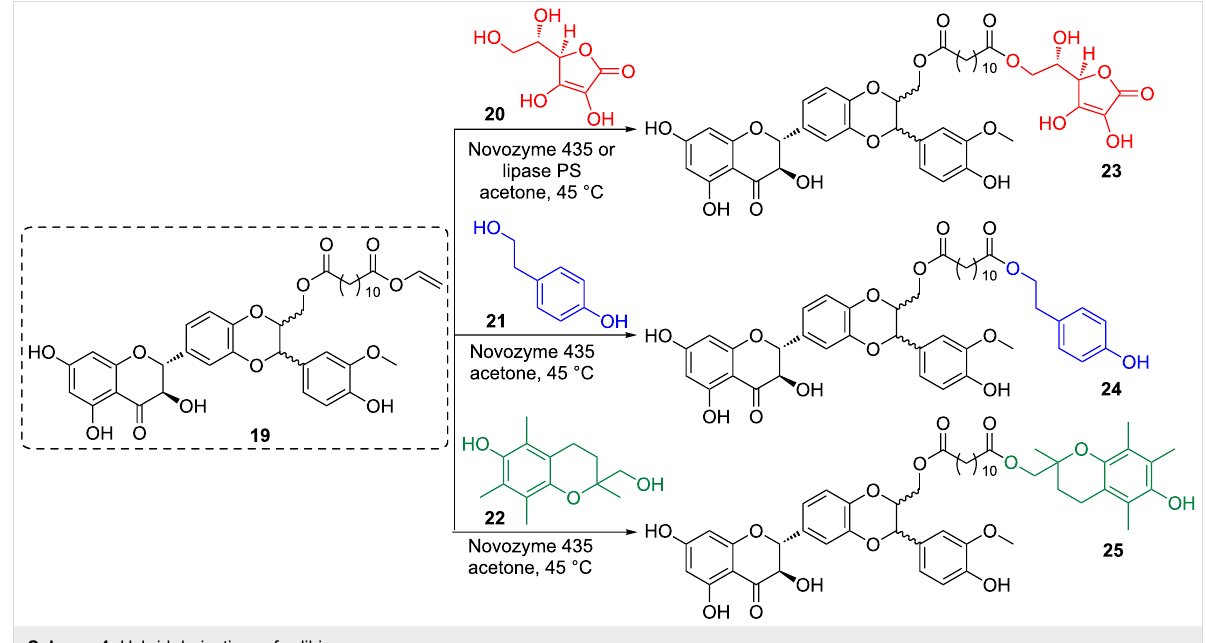
Scheme 4: Hybrid derivatives of sylibin.